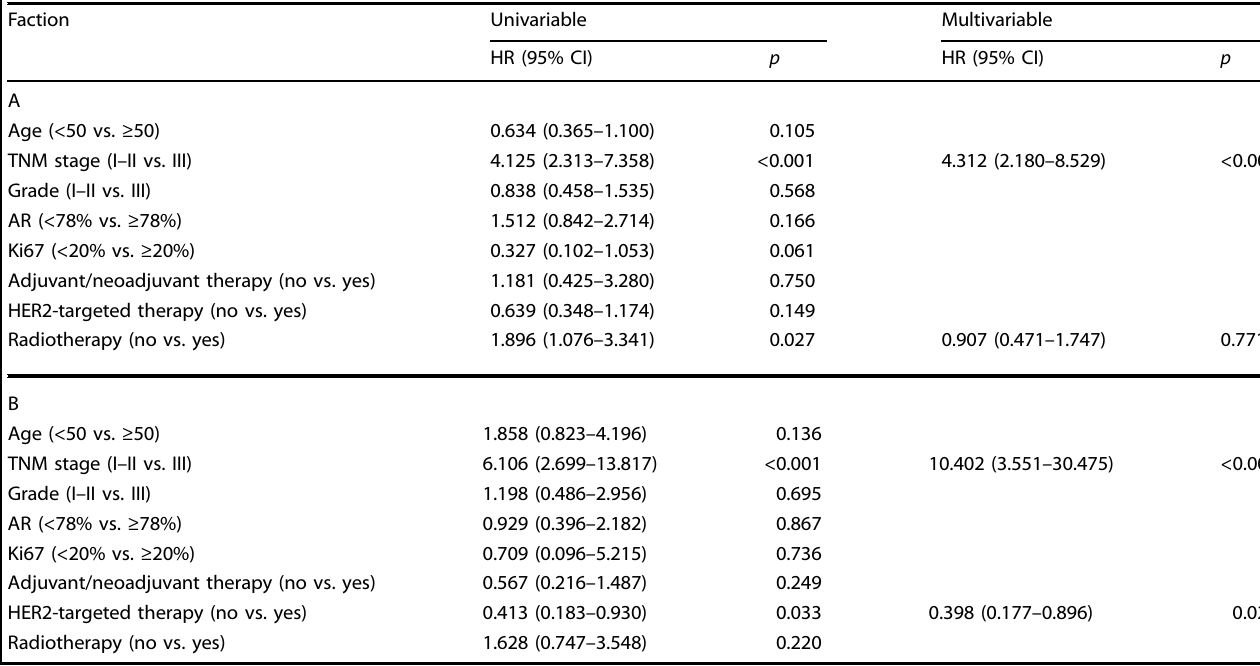
Table 5. Cox proportional hazard regression analysis of DFS (A) and OS (B) in HER2 + HR − breast IDC patients with AR cut-off of 78%. Faction